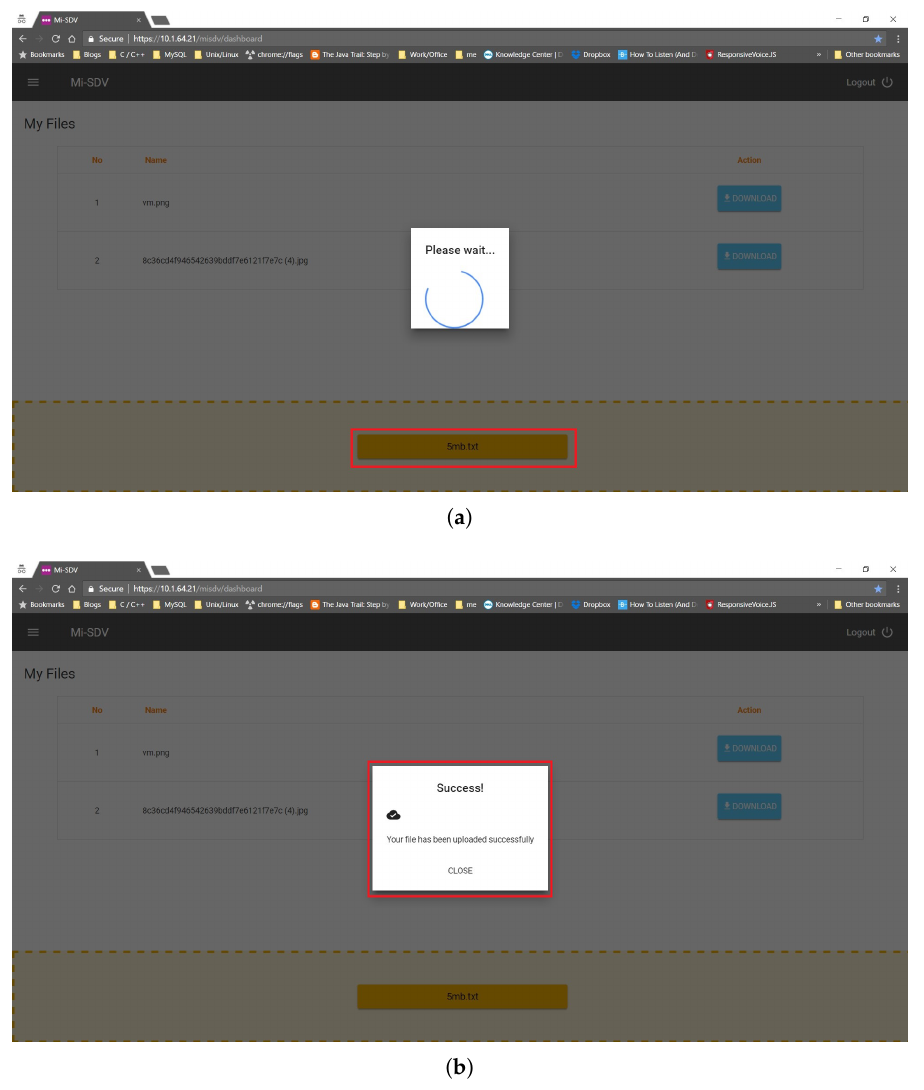
Figure 6. Submitting a document. ( a ) Uploading file; ( b ) Upload